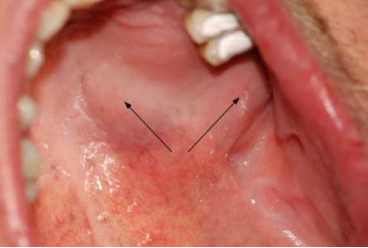
Figure 2. Painless swelling of the hard palate and the alveolar process.